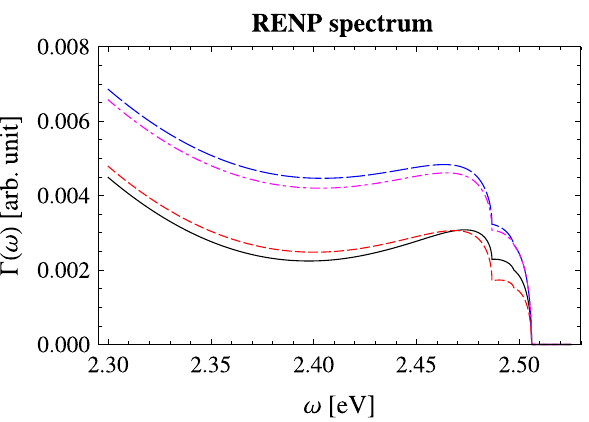
Fig. 3 CPV phase (α,β − δ) dependence of spectrum: Comparison of normal ordering (NO) spectra with a parallel initial phase memory of r = 0 . 9: Dirac in solid black, Majorana (α = 0 ,β − δ = 0 ) in long-dashed blue, Majorana (α = π/ 2 ,β − δ = 0 ) in short-dashed red, and Majorana (α = 0 ,β − δ = π/ 2 ) in dash-dotted magenta for the smallest mass of 50